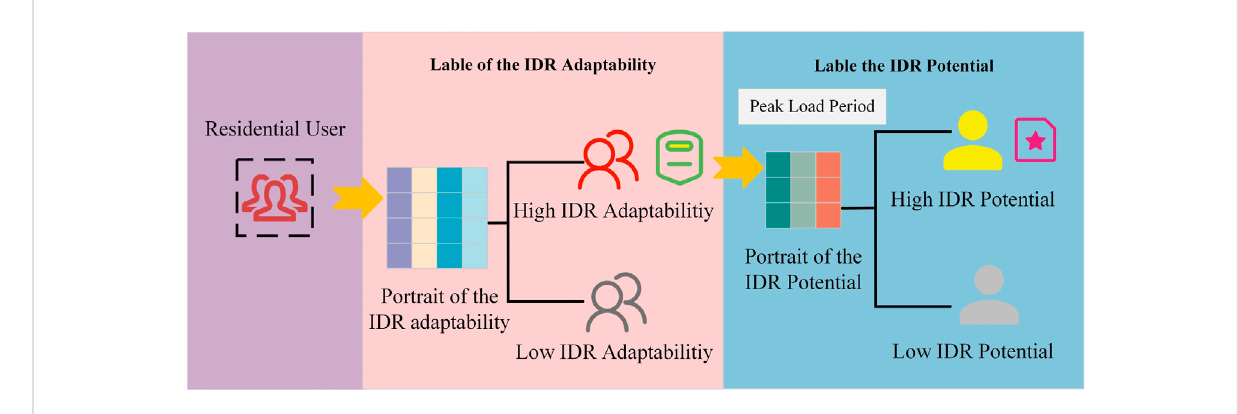
FIGURE 1 The labeling process of the graded user portrait.